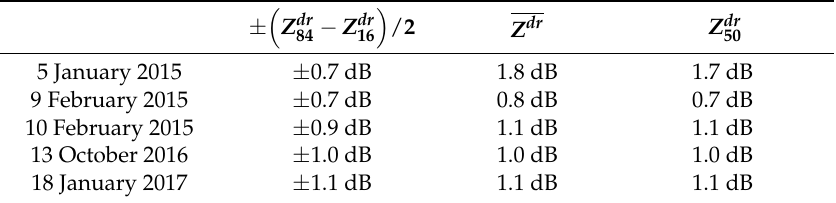
Table 5. Spread, average and median values derived using 5-min differential reflectivity samples.